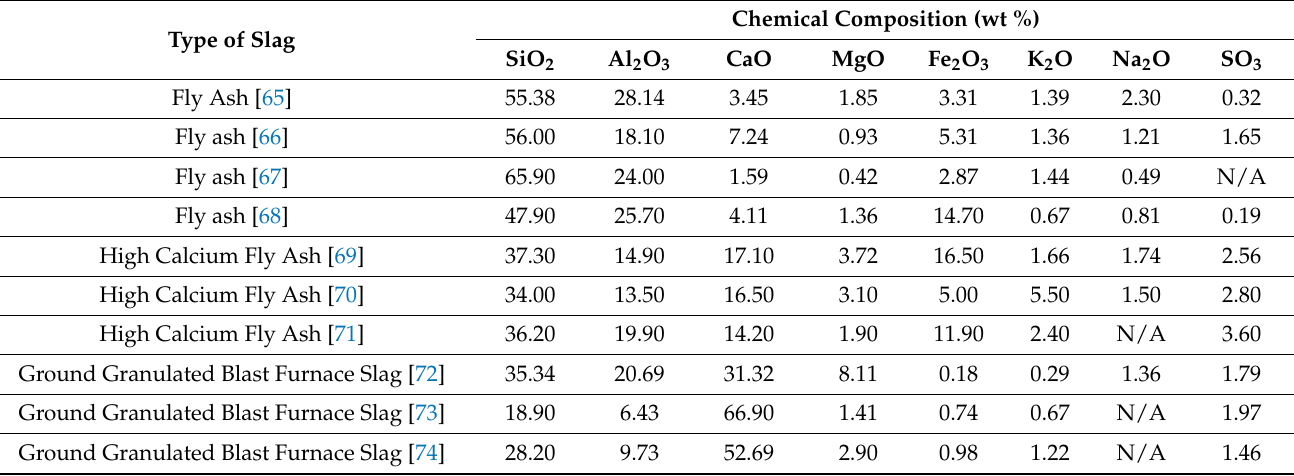
Table 3. Chemical composition of various waste by-product